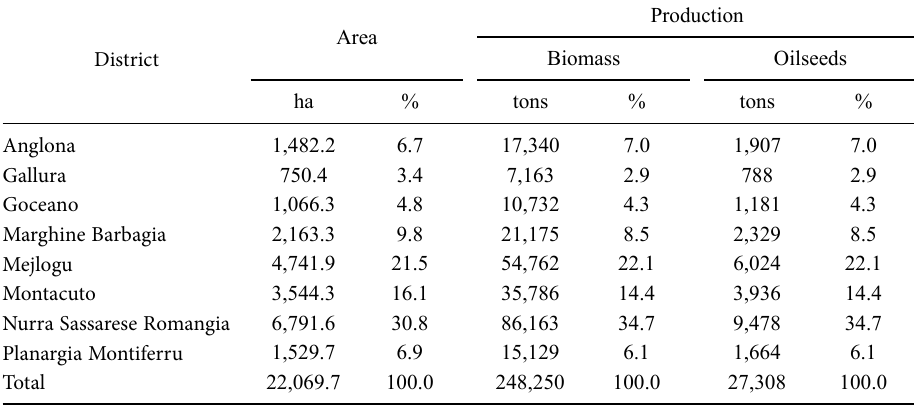
Table 2. Area and production of cardoon in the local districts involved in the project, Sardinia, Italy. Production Area Biomass Oilseeds District ha % tons % tons % Anglona 1,482.2 1,907